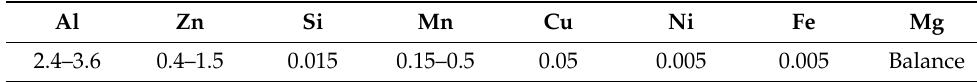
Table 3. Chemical composition of AZ31 filler wire (in wt. %) [33].